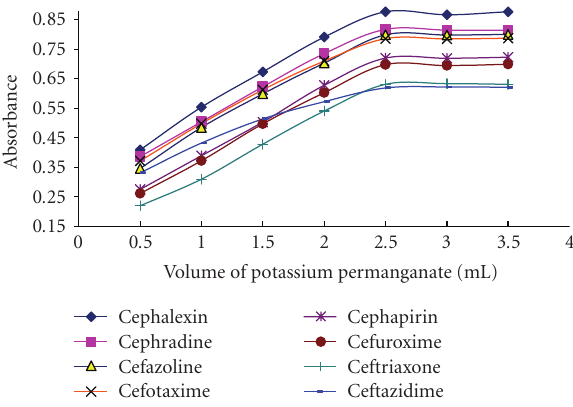
Figure 2: E ff ect of potassium permanganate (3 × 10 − 6 ) on the reaction between the investigated cephalosporins (15 μ gmL − 1 ) and alkaline potassium permanganate.